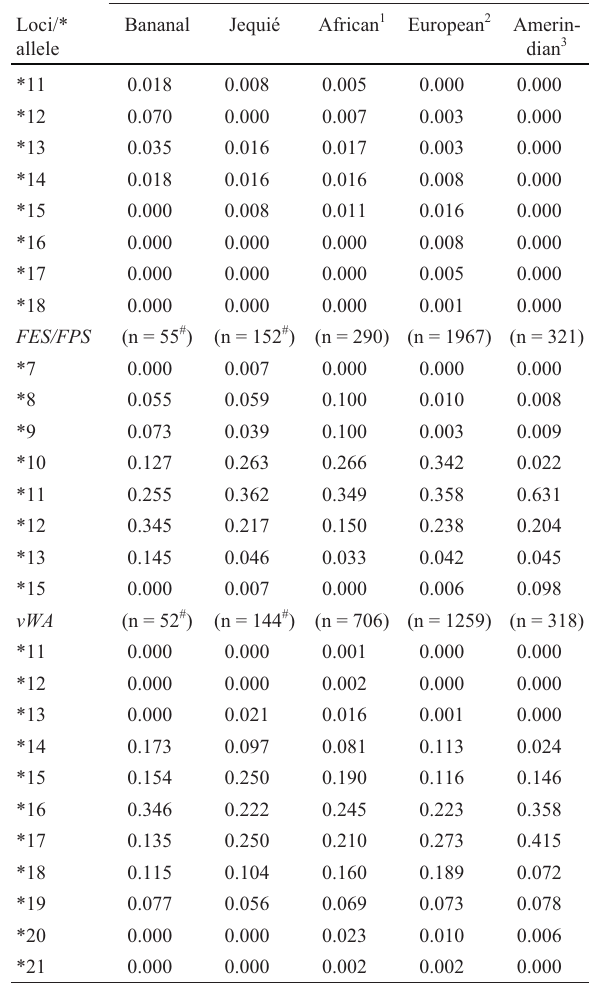
Table 1 - Distribution of allelic frequencies for some short tandem repeat (STR) microsatellite loci and their alleles occurring in populations of African descent in the Brazilian towns of Bananal and Jequié (both in the state of Bahia) and in the parental populations. The frequencies of the most common alleles are in bold type. Asterisks indicate